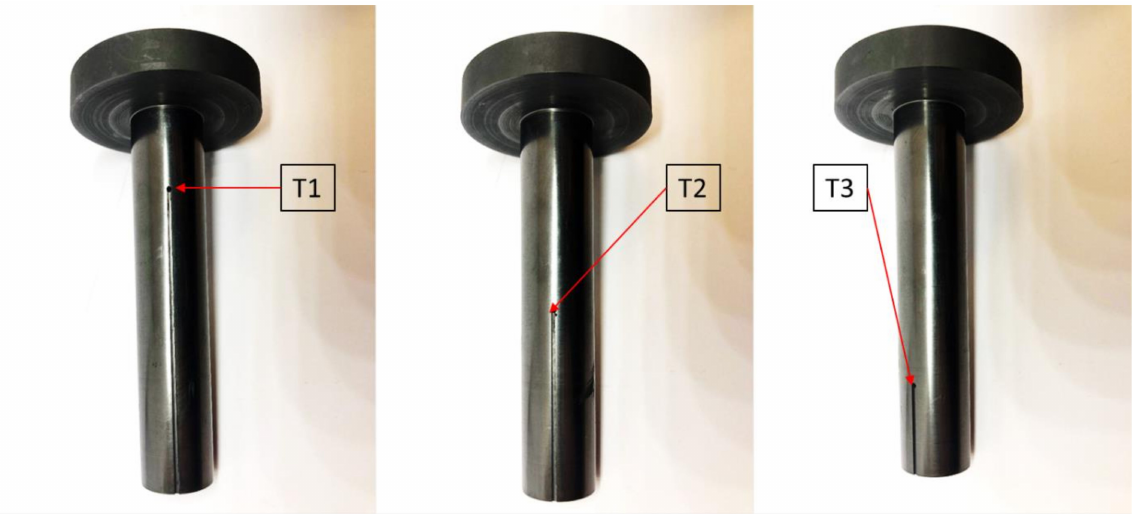
Figure 3. Graphite crystallizer with 3 points of measurement (T1)–at the beginning of the crystallizer, (T2)–in the middle of the crystallizer, (T3)–at the end of the